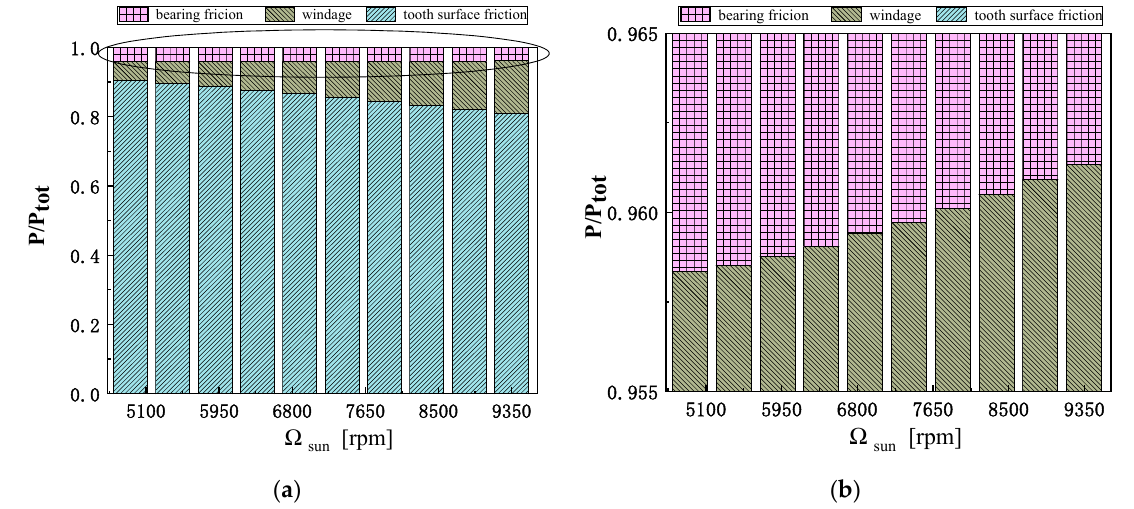
Figure 12. Power loss distribution according to the rotational speed for an input power of 424 Kw. ( a ) Power loss distribution according to the rotational speed; ( b ) partially enlarged view of the figure. Under high-speed and heavy-load conditions, owing to the relatively high sliding speed of the meshing tooth surface, the instantaneous temperature rise directly affects the internal temperature of the gear system. As shown in Figure 13, the higher the tooth surface temperature, the smaller the power loss, because the viscosity of the lubricating oil decreases with the increasing temperature.